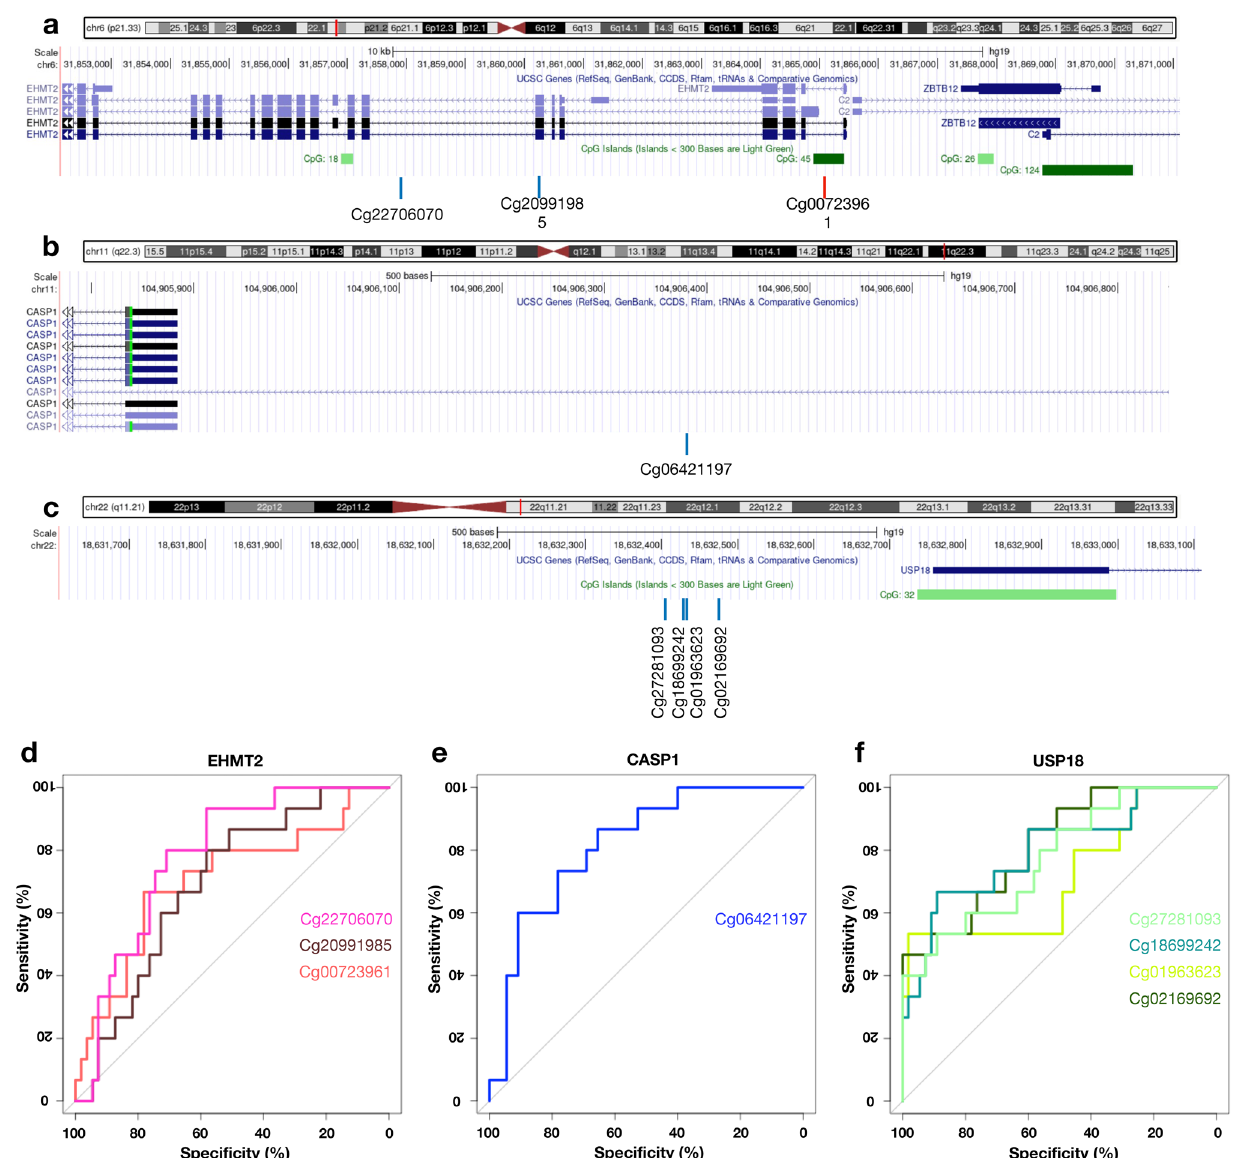
Figure 5. Genomic location and specificity of the unique differentially methylated regions in ASD with CHD8 variants. Genomic location on Euchromatic Histone Lysine Methyltransferase 2 (EHMT2) ( a ), Caspase 1 (CASP1) ( b ) and Ubiquitin Specific Peptidase 18 (USP18) ( c ): blue line represents hypomethylation, the red line represents hypermethylation. The receiver operating characteristic (ROC) analysis of the unique differentially methylated regions of ASD with CHD8 variants (n = 15) was performed against non-ASD (n = 48) and ASD with 16p11.2 deletion (n = 7). Specificity and sensitivity of the unique differentially methylated regions for EHMT2 ( d ), CASP1 ( e ) and USP18 ( f